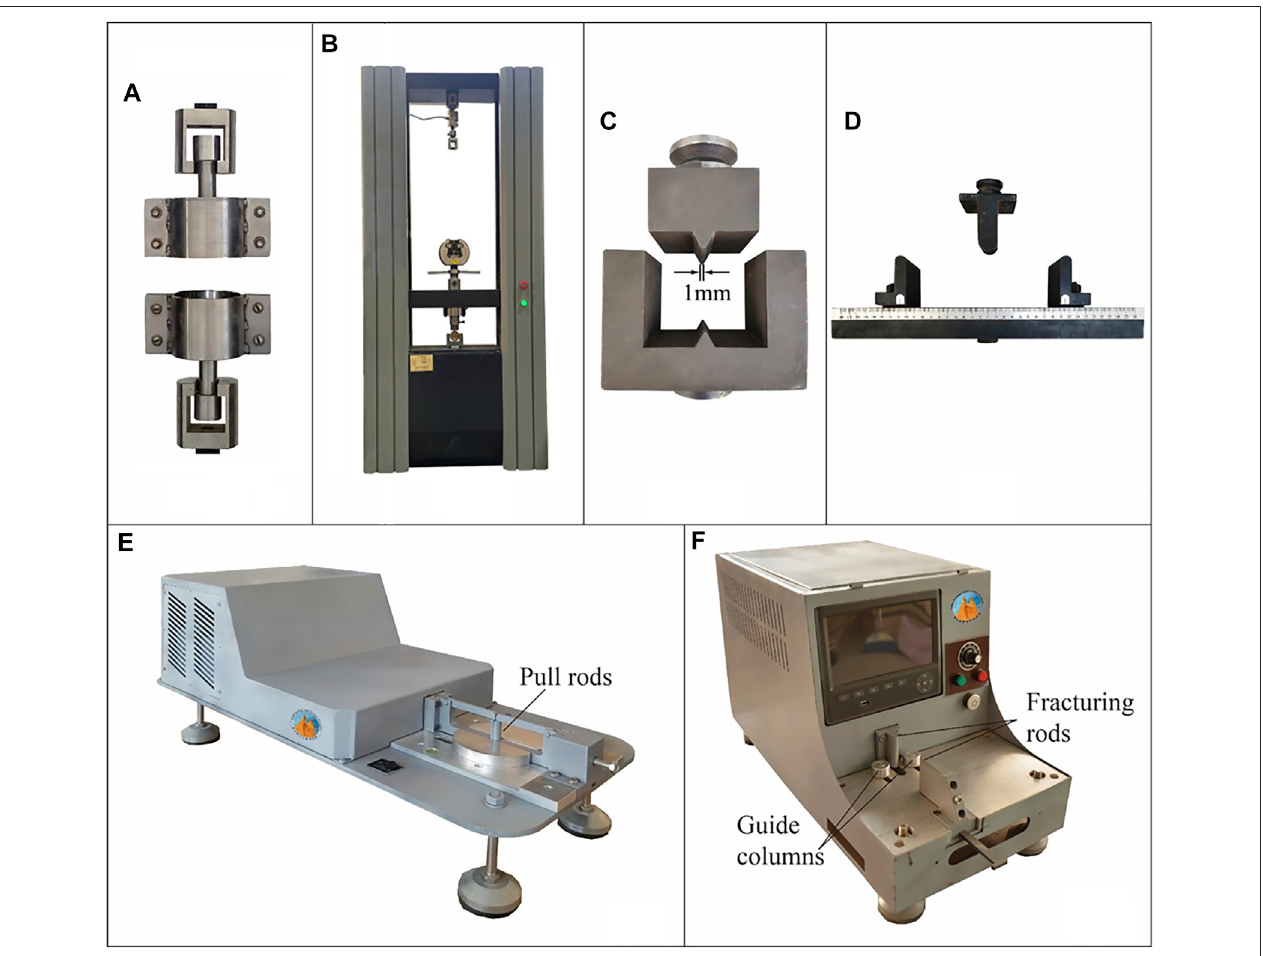
FIGURE3| Testingapparatusesandauxiliaries (A) metalholder(rigidsleeves)forUDTT, (B) universaltestingmachine, (C) narrowlinearjawsforBT, (D) supporting and loading anvils for TPBT, (E) IHFT apparatus (Li et al., 2020), and (F) HCT apparatus (Guan et al., 2022).